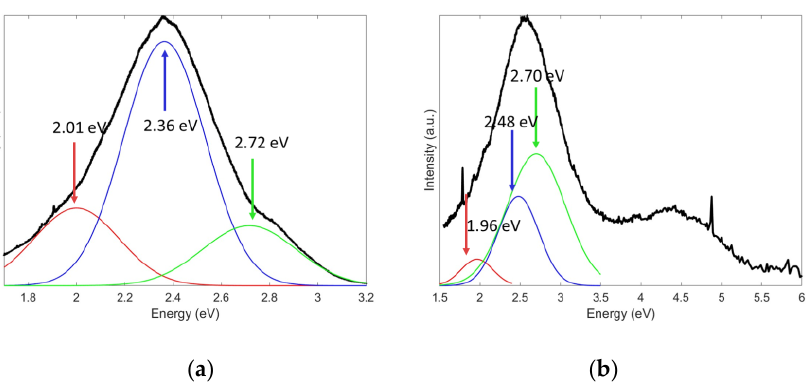
Figure 9. Characteristic luminescence spectra: ( a ) PL at an excitation wavelength of 325 nm; ( b ) CL at an accelerating voltage of 20 keV.